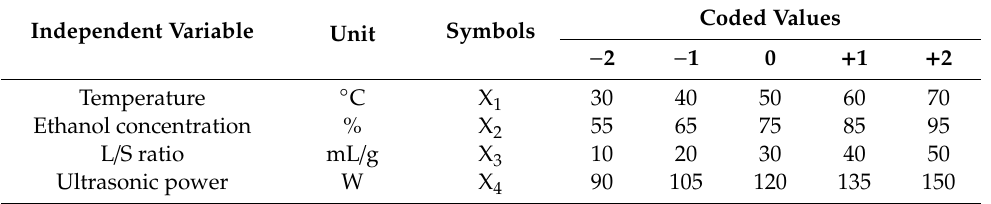
Table 1. Coding of experimental parameters and related levels.